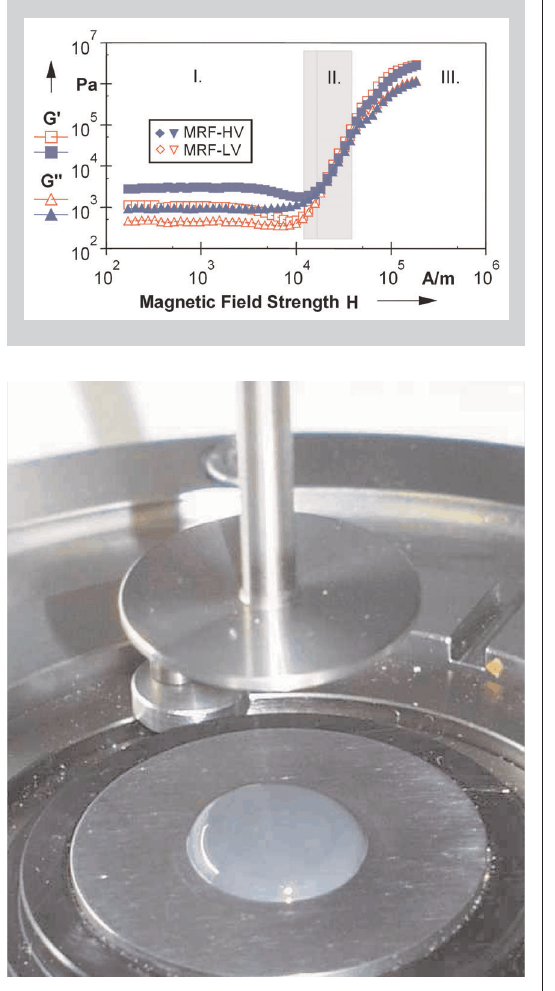
Figure 9 (below): Magneto-sweep: Oscillatory test with logarithmically increasing magnetic field strength showing the const. increase of the complex viscosity | h * | function in Region II. and the loss factor tan d = G’’/G’ with its